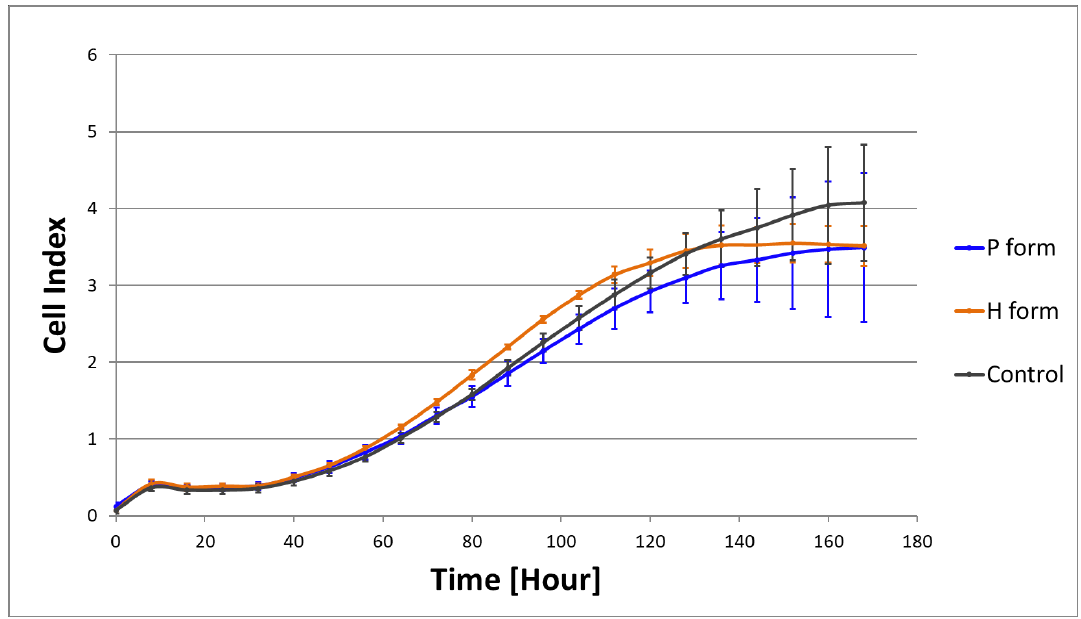
Figure 5. Proliferation of human dermal fibroblasts indicated by the Cell Index in extracts from the P form and the H form of Hcel ® NaT, and in the control culture DMEM medium. Measured by the real-time xCELLigence ® monitoring system for 168 h with 8-h intervals. Arithmetic mean ± S.D. from four independent samples for each type of material.